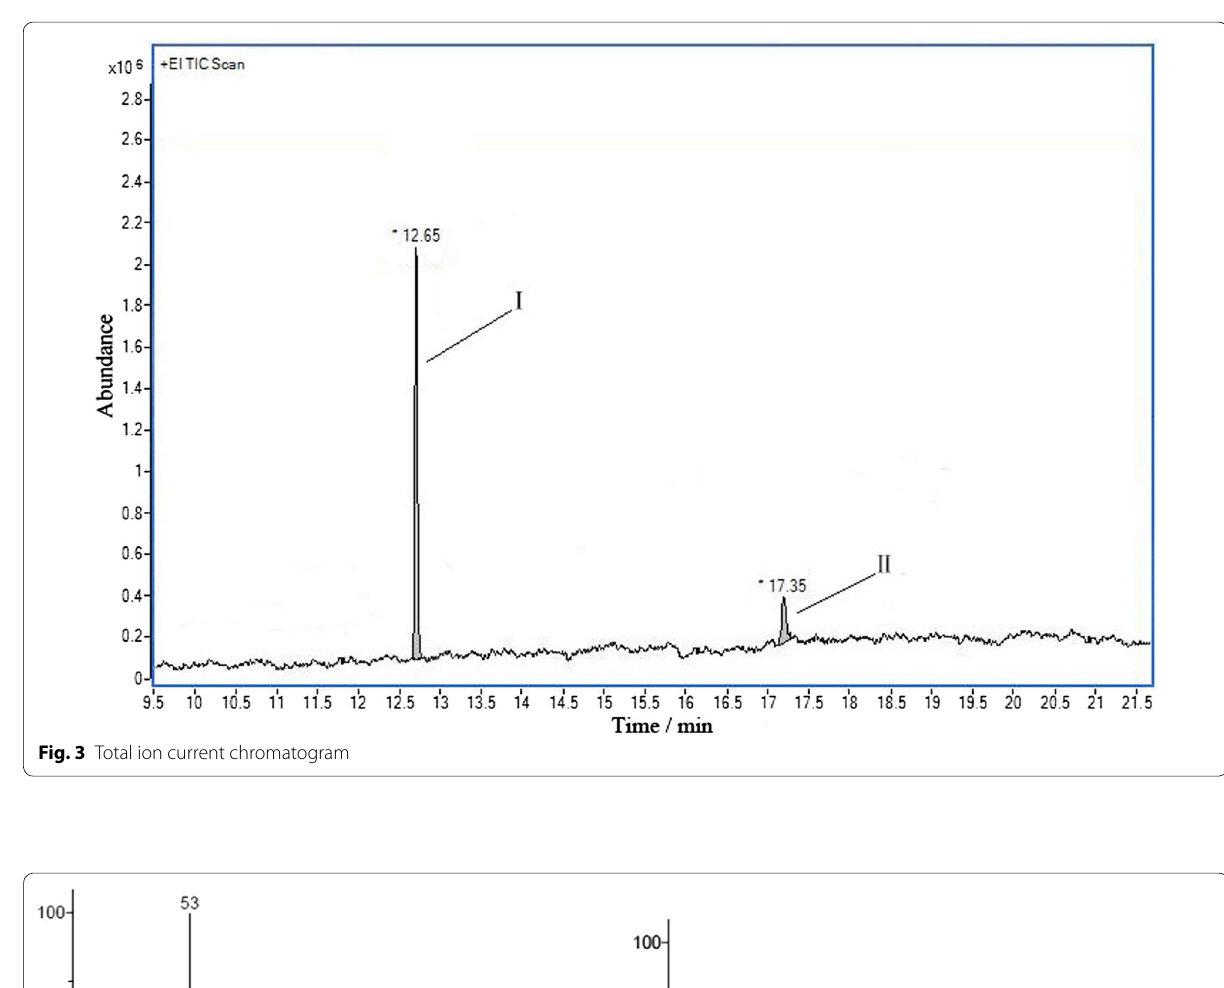
Fig. 3 Total ion current chromatogram